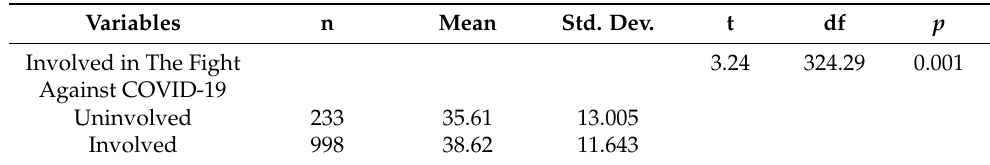
Table 3. Personal implication/age of participants.